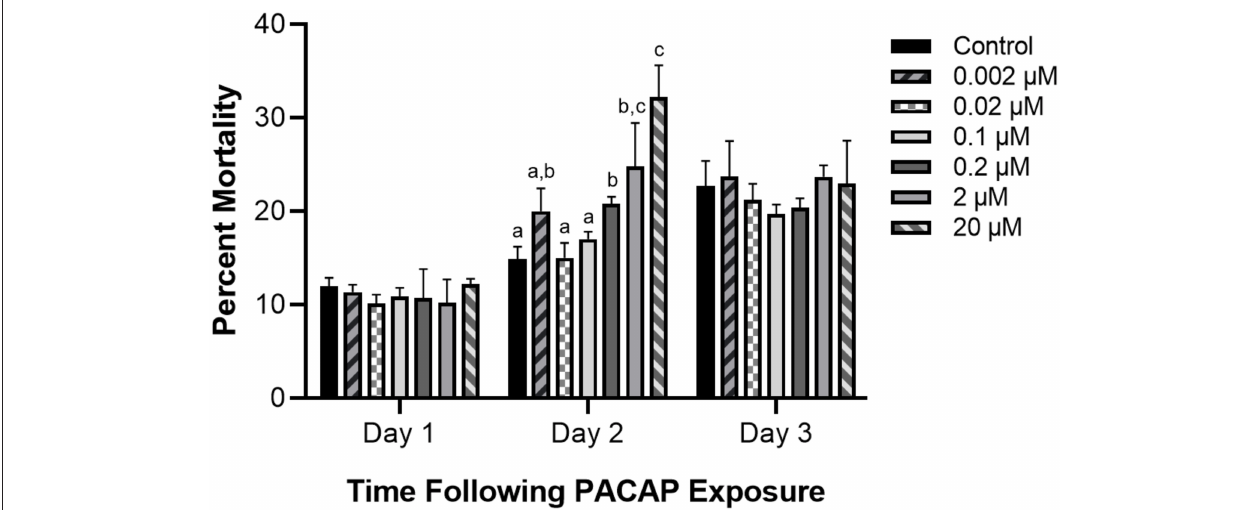
FIGURE 2 | Impact of C. gariepinus PACAP-38 on RTS11 viability. RTS11 was exposed to varying concentrations of PACAP ranging from 0–20 µ M and the percent mortality of RTS11 was determined for each concentration using a trypan blue assay. This figure represents three independent experiments where a p < 0.05 was considered to be significantly different when compared to the no PACAP control for individual timepoints. All vertical error bars represent the standard deviation (SD). Lowercase letters denote significant differences at p <